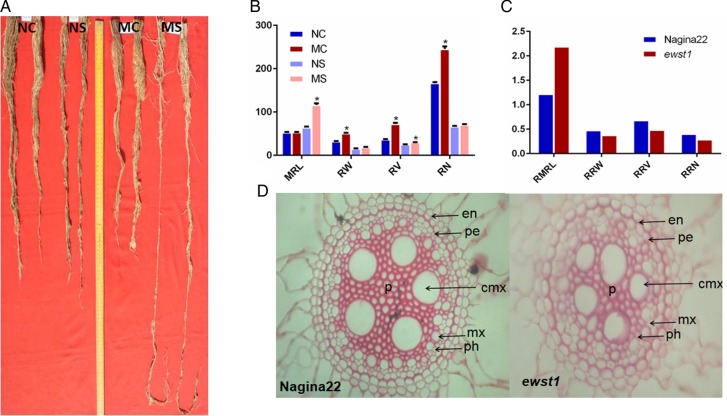
Comparative root study of ewst1 and the WT. (A) Development of root in a PVC tube under control and stress conditions. (B) Comparison of root traits like MRL, RW, RV and root number (RN) under control and stress conditions. (C) Relative values of maximum root length (RMRL), relative root weight (RRW), relative root volume (RRV) and relative total root number (RRN) under control and stress. (D) Anatomy of root magnifying the stele region (en, endodermis; cb, casparian band; pe, pericycle; cmx, central meta-xylem; mx, meta-xylem; ph, phloem; p, pith). Values are mean ± SE of three individual replications. Statistical significance determined using the Holm–Sidak method, with α = 5.0 %. Asterisks indicate significant differences between ewst1 and WT (Student's t-test: P < 0.05).